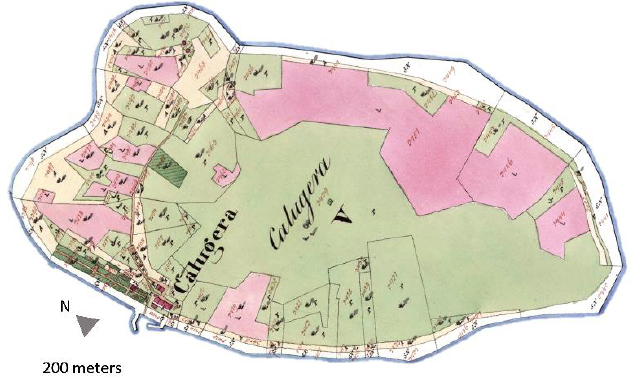
Figure 5. Cadastral map of Ošljak from 1824 (Franciscan survey).